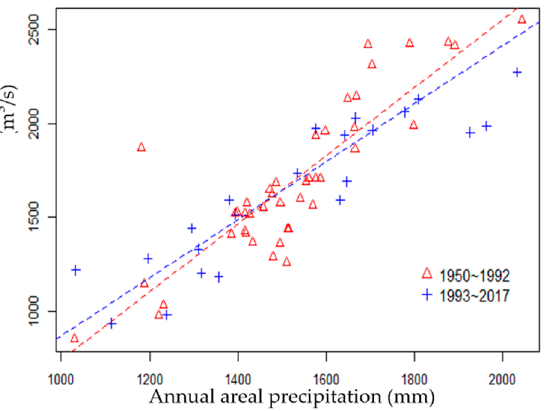
Figure 12. Variation of ( a ) annual precipitation and ( b ) runoff coefficient above Zhuqi.